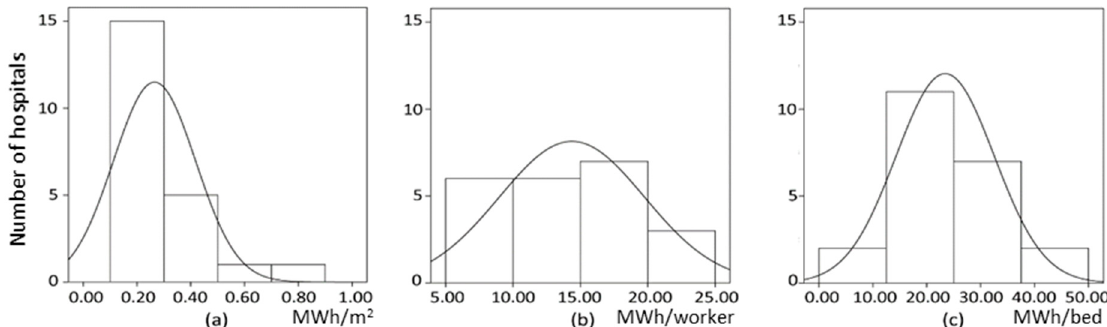
Figure 7. Average consumption in MWh of energy for each indicator: ( a ) built surface area (MWh/m 2 ), ( b ) the number of workers (MWh/worker), and ( c ) the number of beds (MWh/bed).